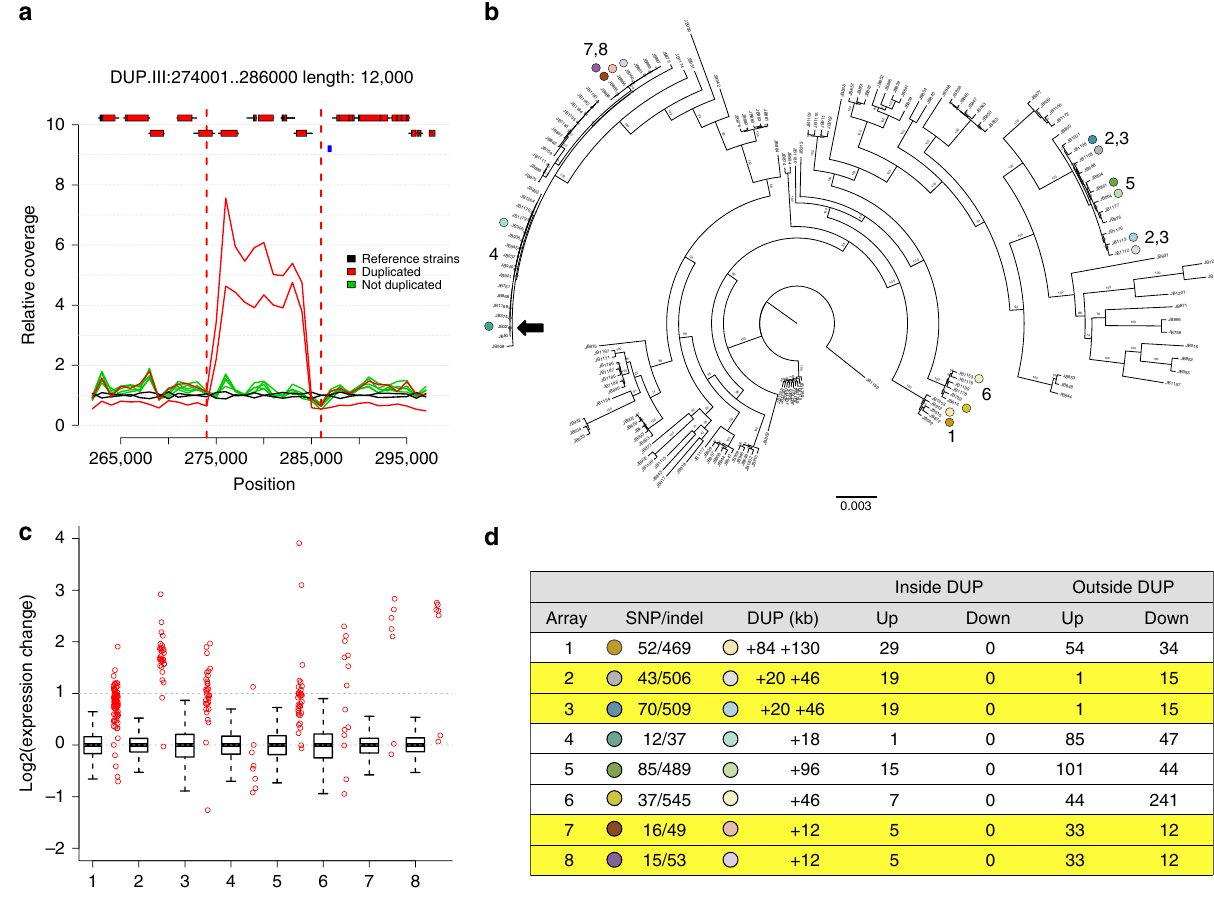
Figure 3 | Transient duplications affect gene expression. ( a ) Duplications occur within near-clonal strains. Plot showing average read coverage in 1kb windows for two clonal strains (JB760, JB886) with the duplication (red), five strains without duplication (green) and two reference strains (h þ , and h (cid:3) ) (black). Genes (with exons as red rectangles) and retrotransposon LTRs (blue rectangles) are shown on top (see Supplementary Table 3 for details). ( b ) Eight pairs of closely related strains, differing by one or more large duplications, selected for expression analysis. The tree indicates the relatedness of these strain pairs (dots coloured as in d ). The position of the reference strain (Leupold’s 972, JB22) is indicated with a black arrow. The scale bar shows the length of 0.003 insertions per site. ( c ) Gene expression increases for most genes within duplicated regions. For each tested strain pair, we show the relative gene expression (strains with duplication/strains without duplication) for all genes outside the duplication (as boxplot) and for all genes within the duplication (red strip chart). In all but one case (array 4), the genes within the duplication tend to be more highly expressed than the genes outside of the duplication (all Wilcoxon rank sum test P values o 1.5 (cid:2) 10 (cid:3) 3 ). Box plots indicate the first quartile, the median and the third quartile; whiskers extend to the most extreme data point, which is no more than 1.5 (cid:2) the interquartile range from the box. ( d ) Summary of expression arrays 1–8, with strains indicated as coloured dots (as in b ), showing number of SNP differences between strains, sizes of duplications in kb (DUP, where ‘ þ X þ Y ’ indicates two duplications with lengths X and Y , respectively). We show total numbers of induced (up) and repressed (down) genes, both inside and outside the duplicated regions. Arrays 2,3 and 7,8 (in yellow shading) are replicates within the same clonal population that contain the same duplications, so we list the number of up- and downregulated genes that are consistent between both arrays. See Supplementary Tables 3 and 4 for